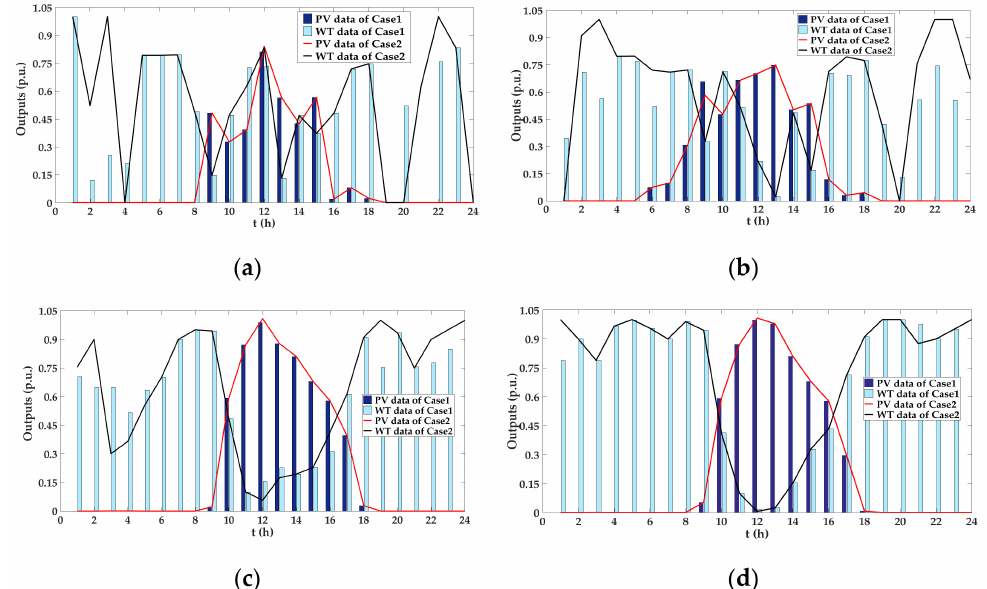
Table 1. Correlated samples in Case 1 and Case 2.